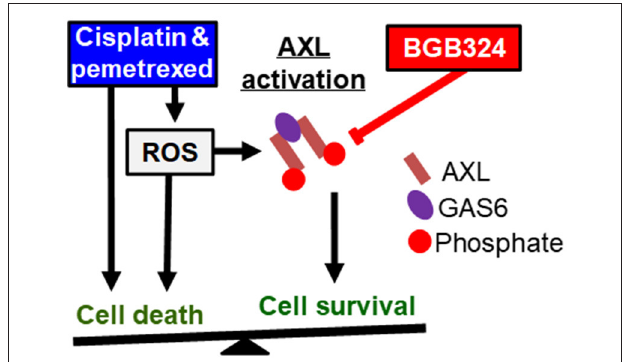
FIGURE 8 | Known pathways and hypothesis for AXL inhibitor (red box) and platinum or antifolate drug (blue box) synergies. Black arrows: Activated AXL promotes cell survival. ROS can increase GAS6 activation and activate AXL independently. Cisplatin and pemetrexed cause cell cycle arrest and increased ROS promoting apoptosis, but ROS-induced AXL activation can inhibit apoptosis. Red line: AXL inhibition can decrease cell survival and promote apoptosis. We have shown adding an AXL inhibitor to current chemotherapy will synergistically promote cell death. This synergy is based on inhibiting an opposing pathway of